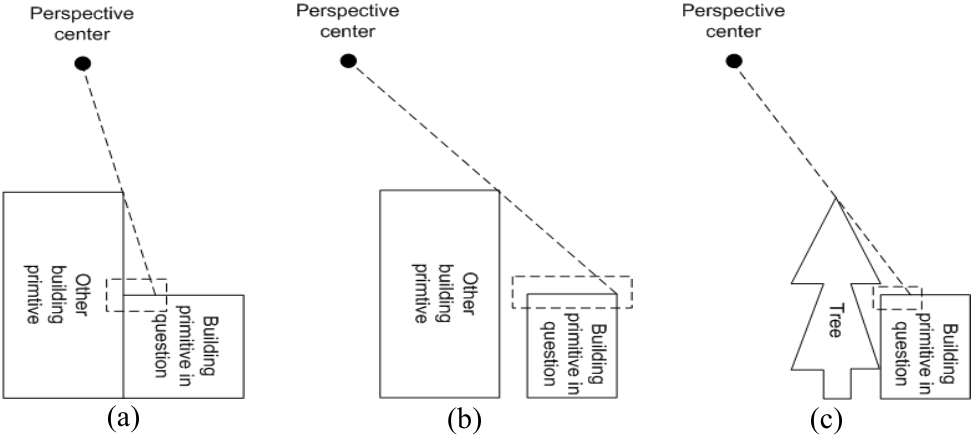
Figure 9. Different types of occlusions: caused by (a) a higher building primitive sharing a vertical wall with the one in question; (b) a higher and non-adjacent building primitive; and (c) trees closely located to the primitive in